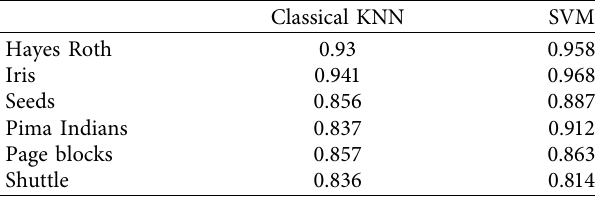
Table 1: Accuracy comparison of classical KNN and SVM.